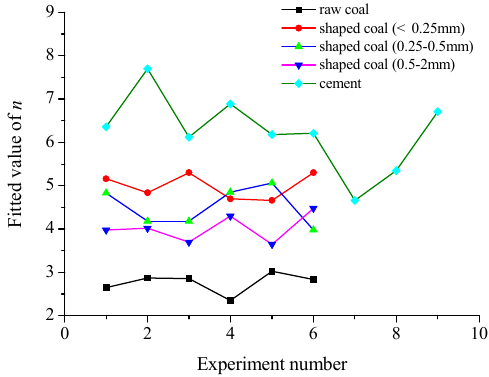
Figure 17. Fitting values of n for three coal and rock materials.